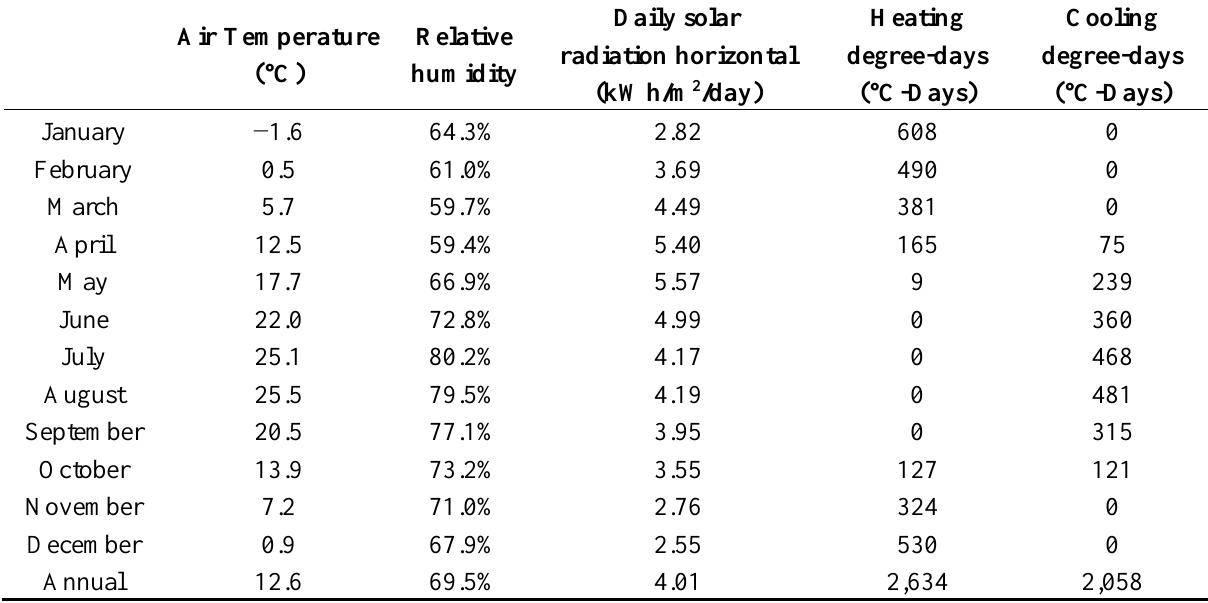
Table 8. Monthly average climatic conditions of test site (Daejeon in Korea, Latitude 36.4° N, 127.4° E, Elevation of 72 m)